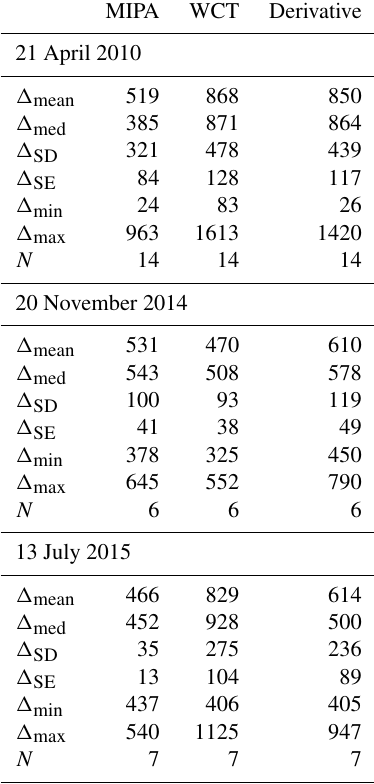
Table 4. Statistical analysis of the absolute differences with respect to the reference of the ABLH retrieved by applying MIPA, WCT and derivative approaches on Potenza high-resolution time series of the total attenuated backscatter at 1064nm in the three selected cases studies (21 April 2010, 20 November 2014, 13 July 2015). The mean ( (cid:49) mean ), the median ( (cid:49) mean ), the standard devia- tion ( (cid:49) SD ), the standard error ( (cid:49) SE ), the minimum and the max- imum of the absolute differences are given in meters. N is the num- ber of points on which the statistics are made. The reference is as- sumed to be the ABLH calculated from the co-located atmospheric temperature and pressure profiles provided by ECMWF